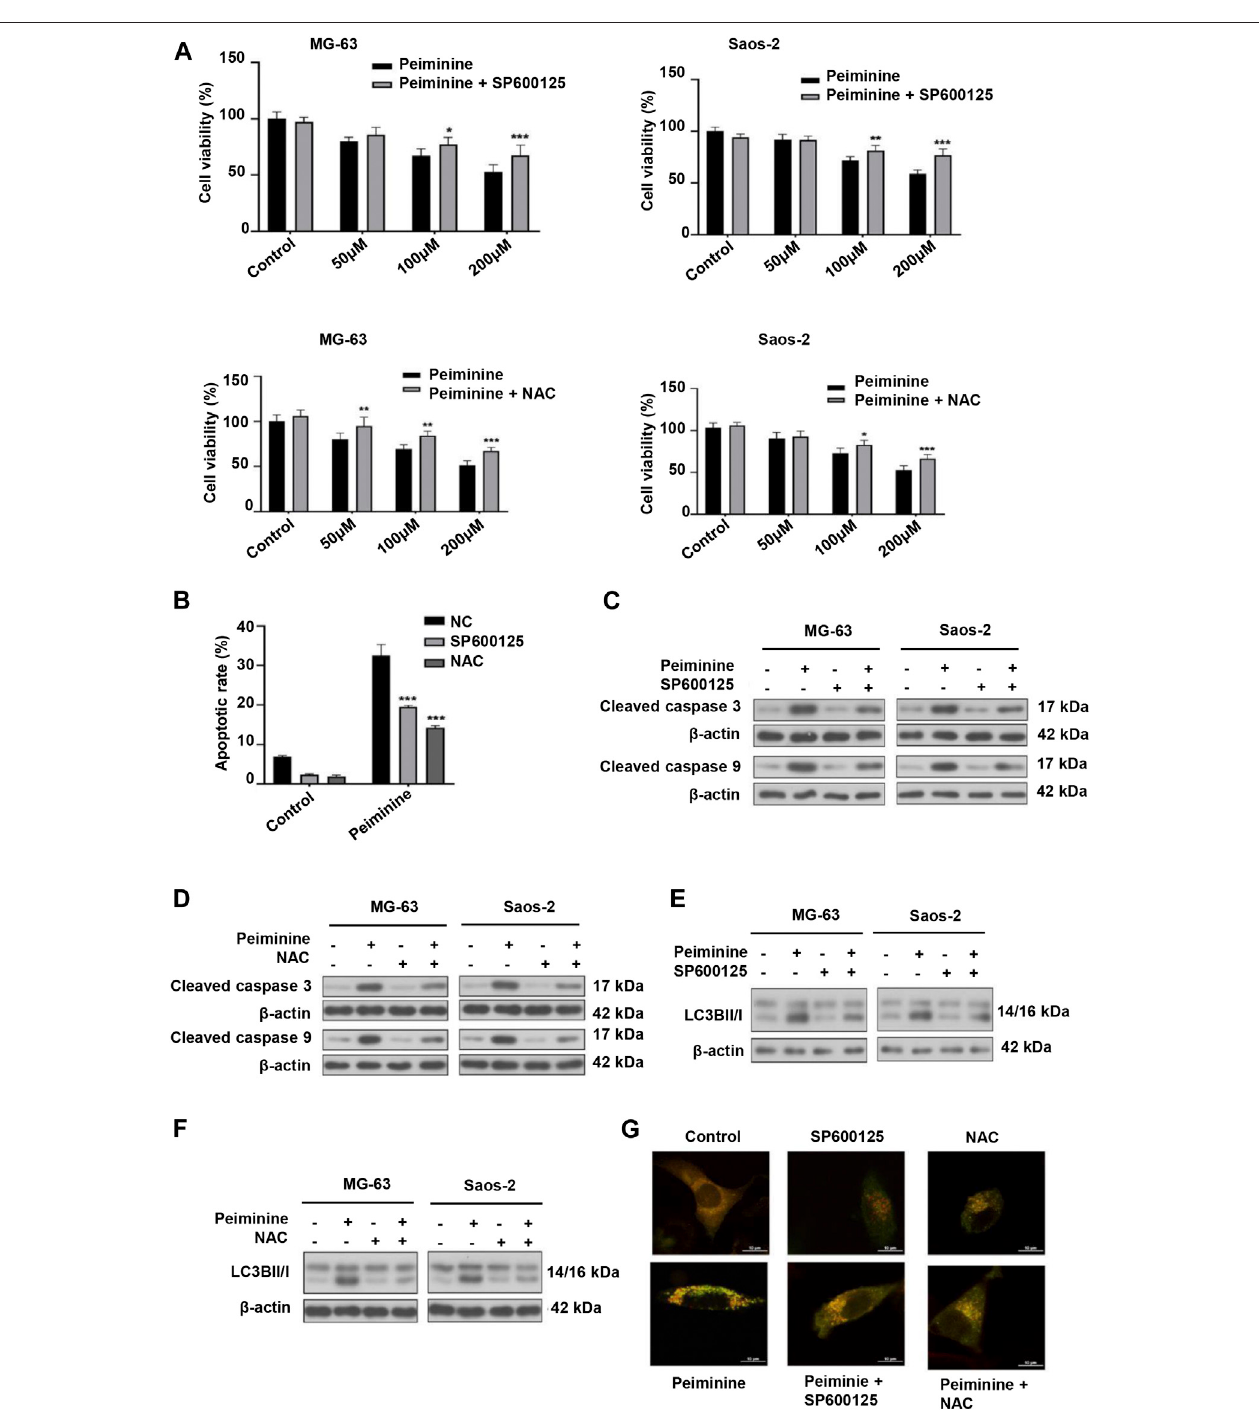
FIGURE 6 | Peiminine induced cell apoptosis and autophagy via the activation of the ROS/JNK signaling pathway. Osteosarcoma (OS) cells were pretreated with SP600125 (30 μ M) or NAC (5 mM) for 2 h and then treated with peiminine (200 μ M) for 48 h. (A) Cell viability was measured by cell counting kit-8 (CCK-8) assay ( n (cid:2) 3). (B) Apoptotic cells were detected by fl ow cytometry ( n (cid:2) 3). (C,D) The expression levels of apoptosis-related proteins and (E,F) autophagy-related proteins were measured by western blot. (G) Representative images of OS cells showing the mRFG-GFP-LC3 puncta. OS cells were pretreated or not with SP600125 or NAC and then incubated with peiminine or vehicle. Scale bar (cid:2) 20 μ m. * p < 0.05, ** p < 0.01, *** p < 0.001.